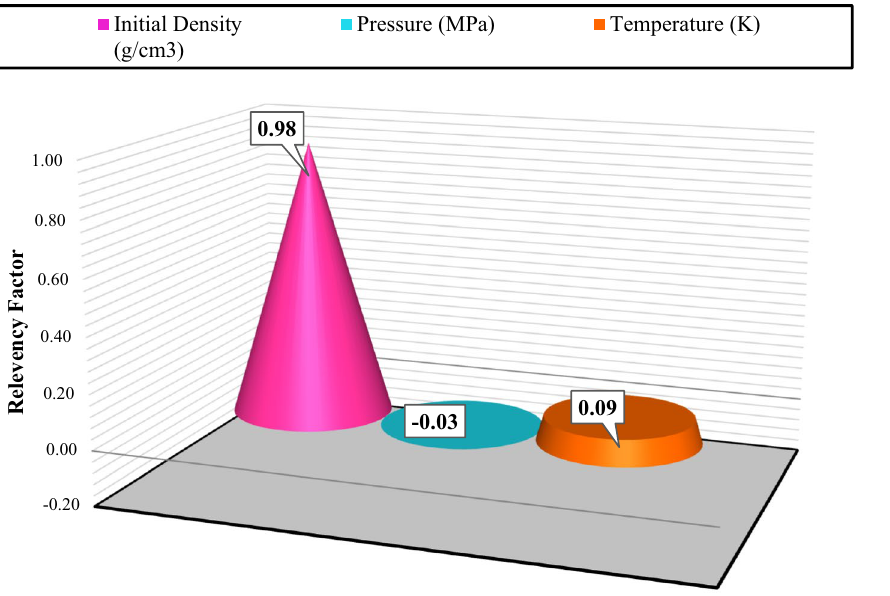
Figure 8. The results of sensitivity analysis for determining input impacts on the output.